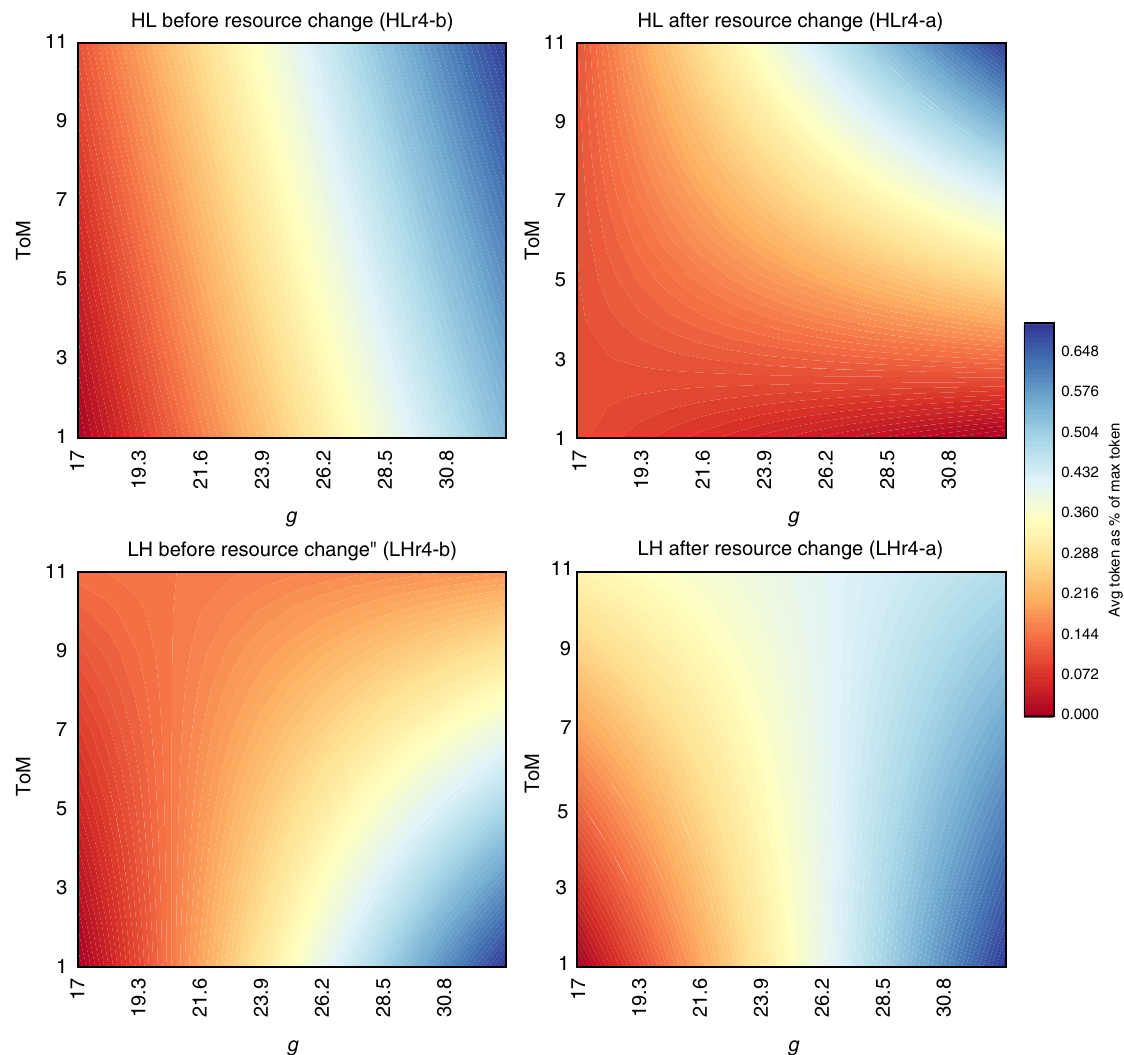
Fig. 4 Effects of g and ToM and change on average tokens collected as % of maximum tokens available. Blue color group harvested less, HL high-to-low resource growth treatment, LH low-to-high resource growth treatment, -b marginal effect when change = 0 (before change), -a marginal effects when change = 1 (after change). The different fi gure panels represent the marginal effects of g and ToM for models Hr4 and LHr4 portrayed in